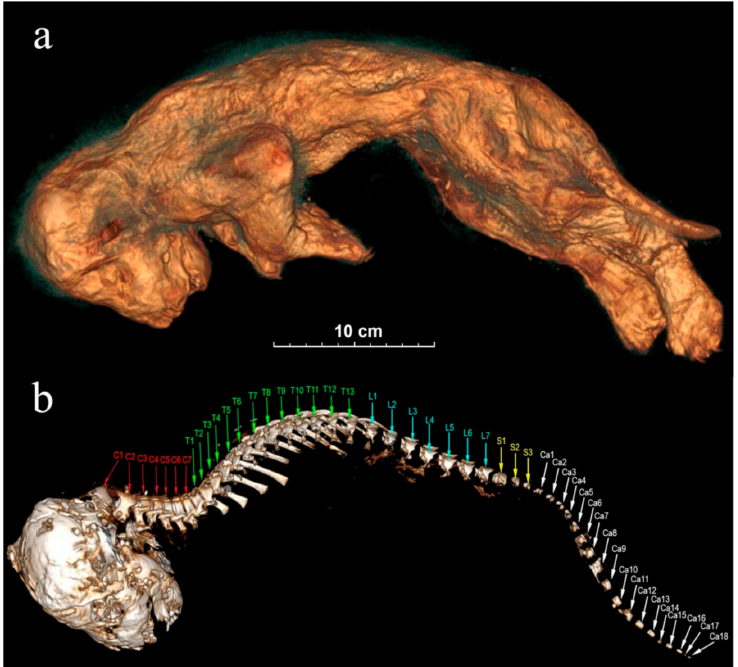
Figure 8. The tomographic images of Sparta’s body from the left side: ( a ) skin; ( b ) skull and spine. The spinal bones: C—cervical vertebrae, T—thoracic vertebrae, L—lumbar vertebrae, S—sacral vertebrae, Ca—caudal